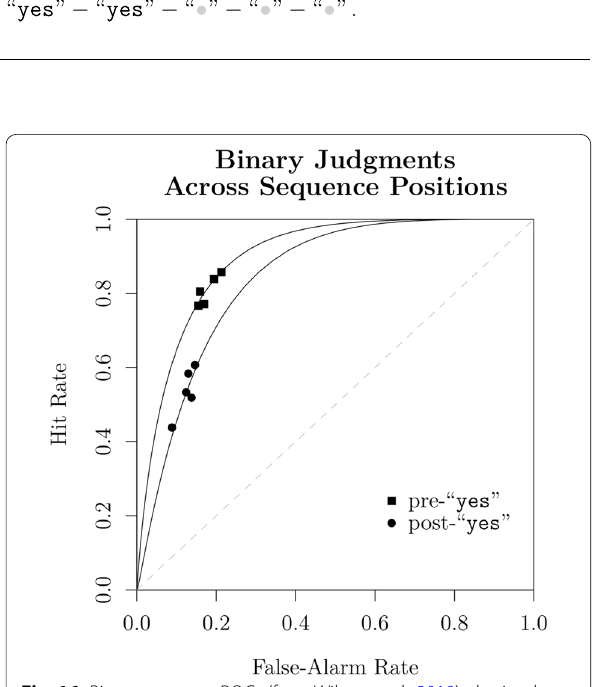
Fig. 16 Binary response ROCs (from Wilson et al., 2019) obtained with marginal responses per sequence position (each point corresponds to a sequence position, from 2 to 6). Black squares denote cases in which no “ yes ” responses were made in any previous positions (pre-“ yes ”). Black circles denote the complementary cases in at least one “ yes ” response was previously made (post-“ yes ”)